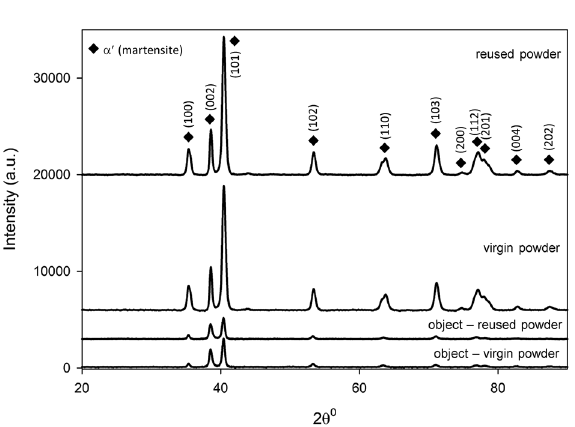
Figure 4. XRD diffractogram for the virgin and reused Ti6Al4V powders and the 3D objects printed from